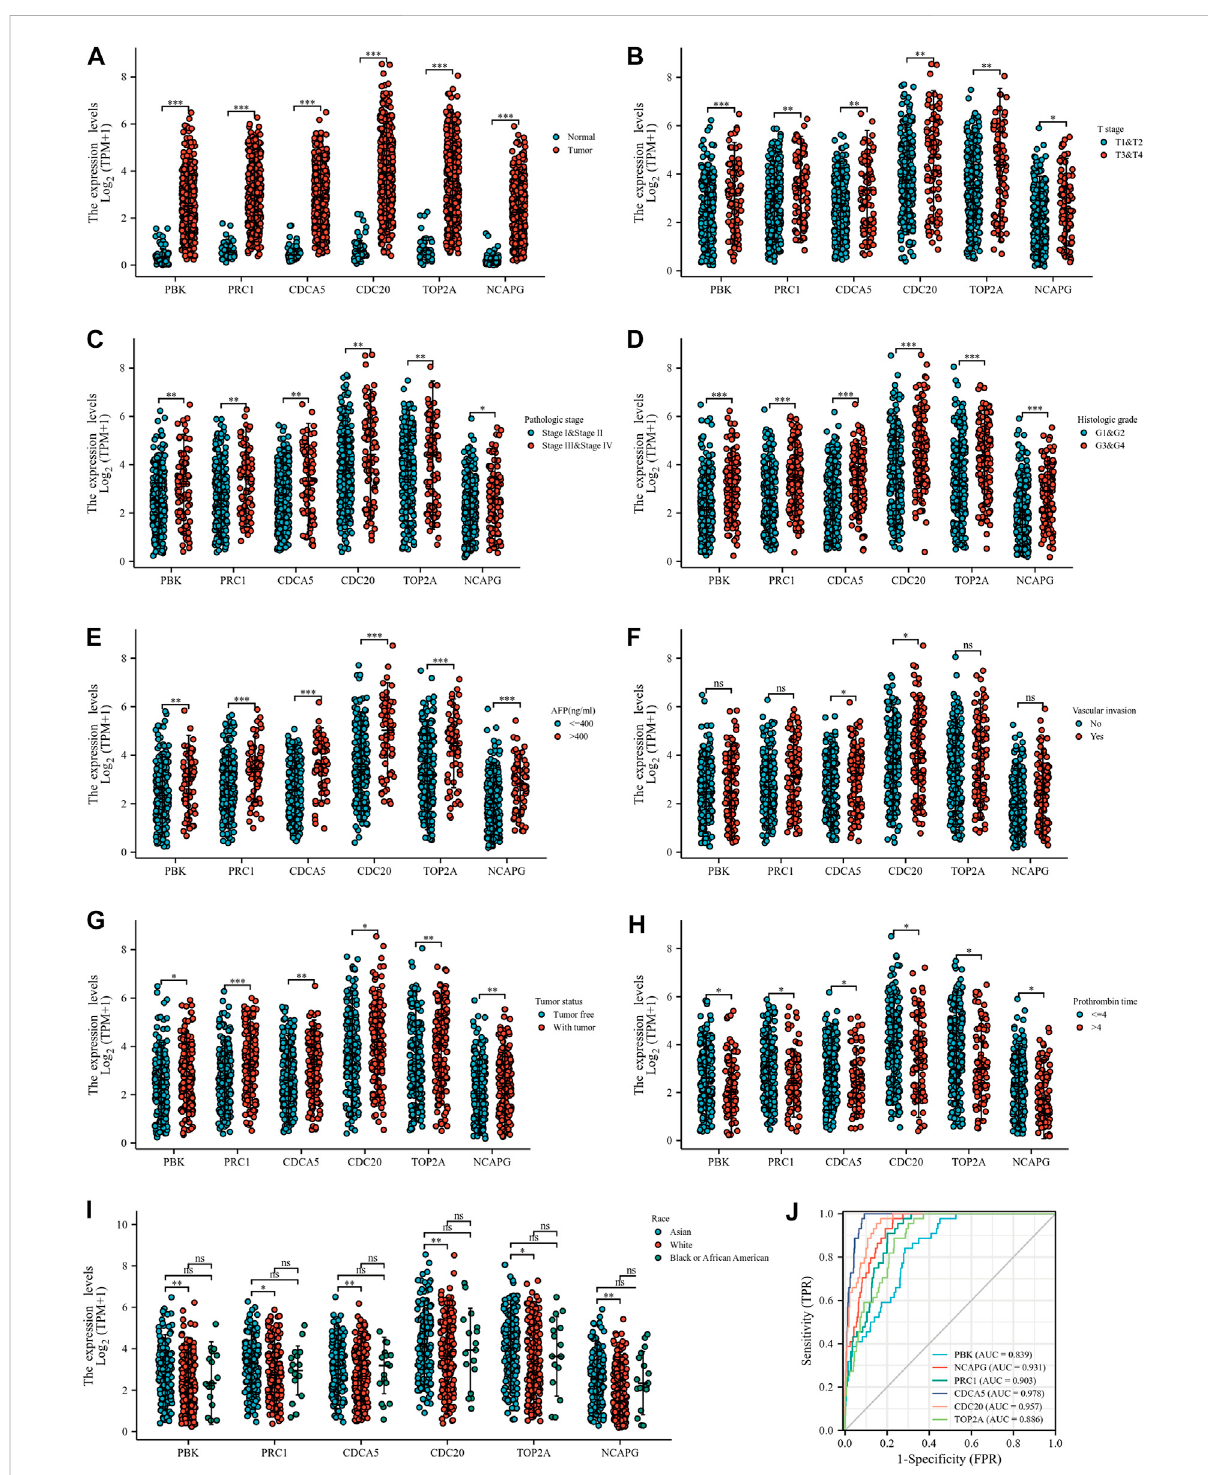
FIGURE 5 Correlation betweenup-regulated hubgenesandclinicopathologicalfeatures. (A) DEG expressions inHCCandnormaltissues basedonTCGA database. (B – I) Correlation between up-regulated DEGs and T stage (B) , pathologic stage (C) , histological grade (D) , AFP (E) , vascular invasion (F) , tumor status (G) , PT (H) , and race (I) . (J) ROC curve of up-regulated DEGs in the diagnosis of